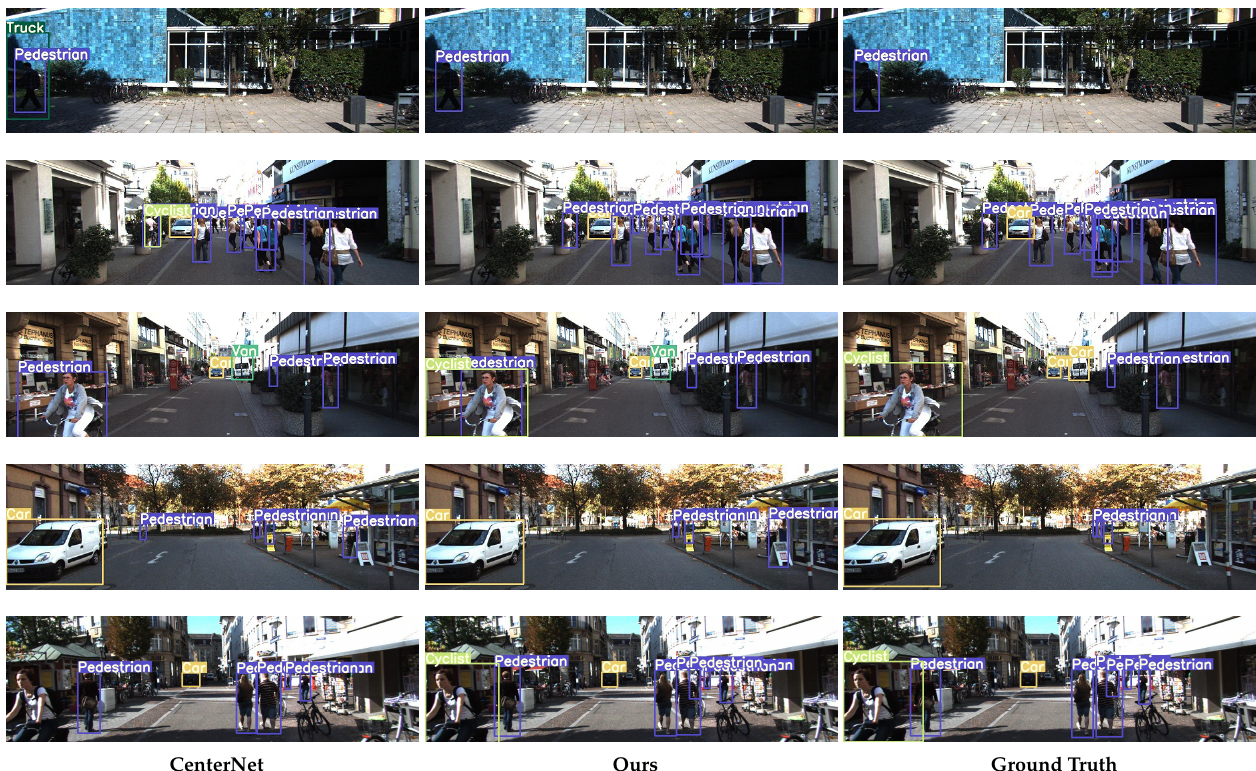
Figure 6. Visualization of detection results on the KITTI dataset. The first column in the figure shows the detection results from the original CenterNet, the second column shows the detection results from SA-CenterNet, and the third column shows the ground truth. These results demonstrate that our method achieves better detection performance for objects of different scales. The object categories are Car, Van, Truck, Pedestrian, Person_sitting, Cyclist, Tram,